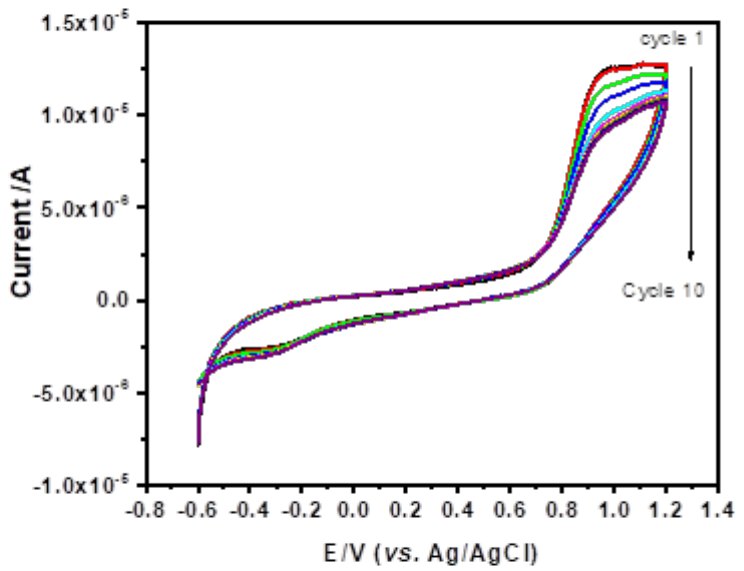
Figure 9. The repetitive cyclic voltammograms for 1 × 10 −3 M fenitrothion in phosphate buffer (pH 8) in presence of CTAB (1 × 10 −3 M).